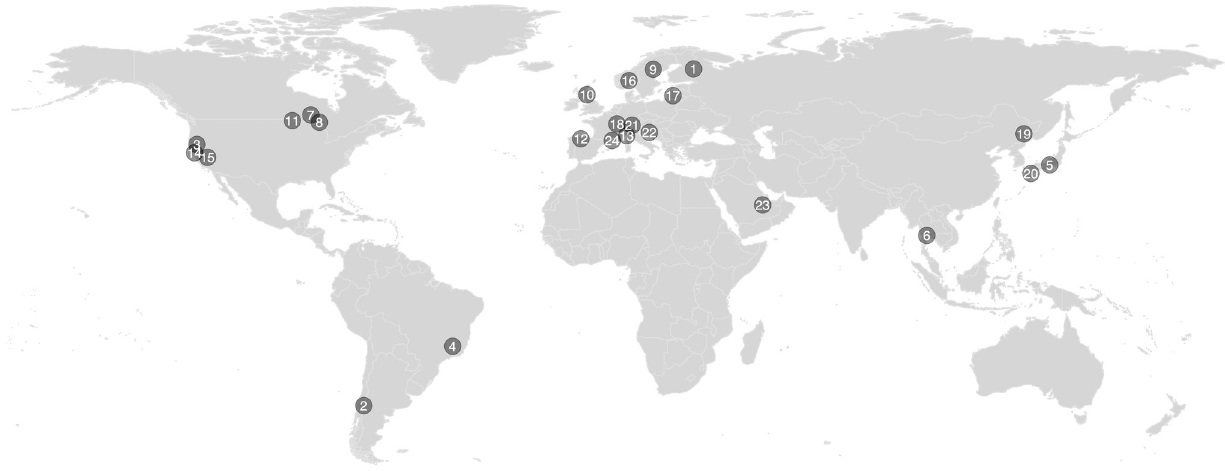
Fig 2. World map showing the geographical disposition of the studies used in this meta-analysis. (1) Aroviita and Ha¨ma¨la¨inen (2008) [39], (2) Valdovinos et al. (2007) [20], (3) Marchetti et al. (2011) [26], (4) Molozzi et al. (2013) [40], (5) Takao et al. (2008) [15], (6) Kullasoot et al. (2017) [16], (7) White et al. (2011) [22], (8) Smokorowski et al. (2011) [25], (9) Englund and Malmqvist (1996) [18], (10) Jackson et al. (2007) [14], (11) Kraft (1988) [17], (12) Mellado-Diaz et al. (2019) [41], (13) Bruno et al. (2019) [42], (14) Milner et al. (2019) [43], (15) Steel et al. (2018) [44], (16) Schneider and Petrin (2017) [45], (17) Vaikasas et al. (2013) [46], (18) Doledec et al. (2021) [47], (19) Wang et al. (2016) [48], (20) Nukazawa et al. (2020) [49], (21) Quadroni et al. (2020) [50], (22) Vilenica et al. (2020) [51], (23) Uieda and Marcal (2020) [52] and (24) Cazaubon and Giudicelli (1999) [53].